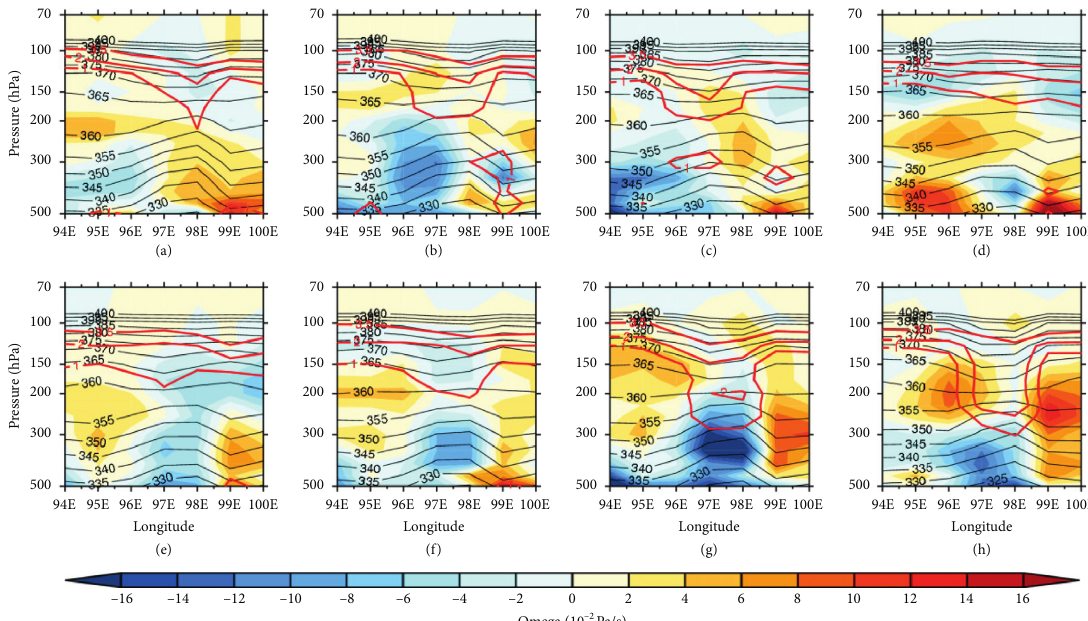
Figure 8: The composites of longitude-pressure cross section of vertical velocity (units:10 − 2 Pa/s, color contours) and potential temperature (units: K, black lines, contour interval: 5K) fields at 34 ° N for the (a) 7th day, (b) 6th day, (c) 5th day, (d) 4th day, (e) 3rd day, (f) 2nd day, (g) 1st day, and (h) 0 day before the OCS onset for 41 OCS events. The red lines show the contours of 1, 2, and 3.5PV